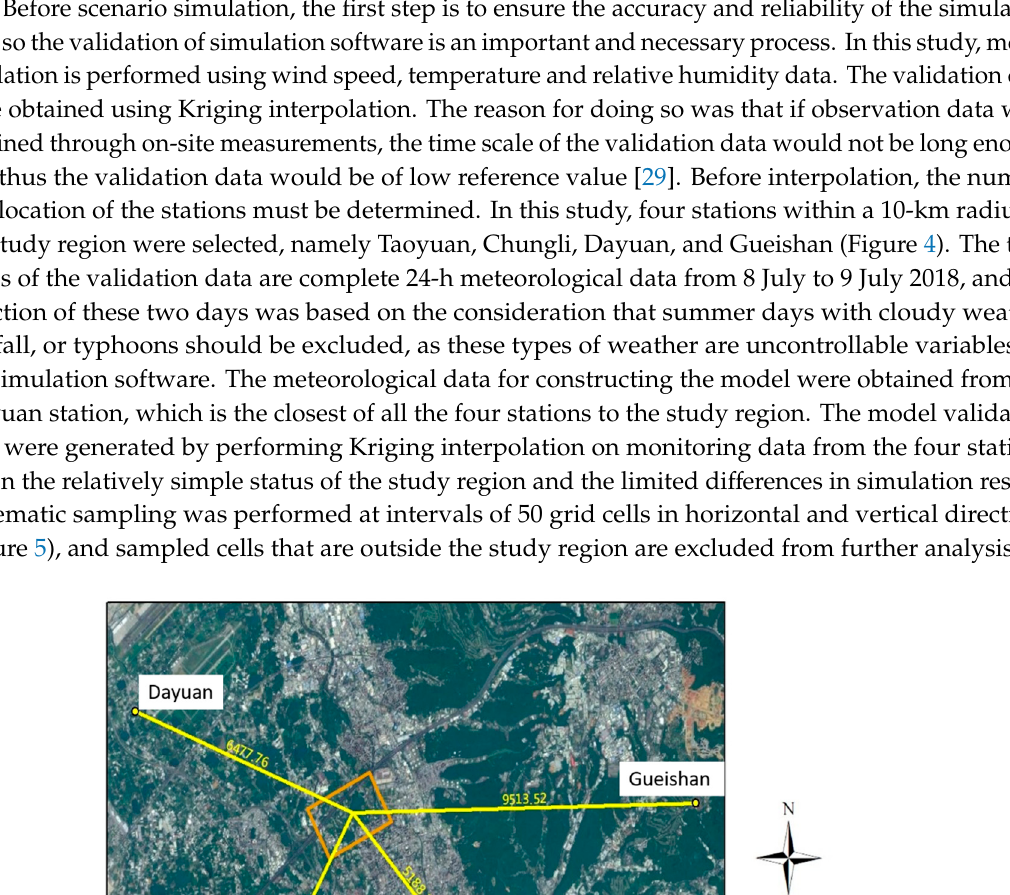
Figure 5. ENVI-met-simulated results and systematic sampling points.